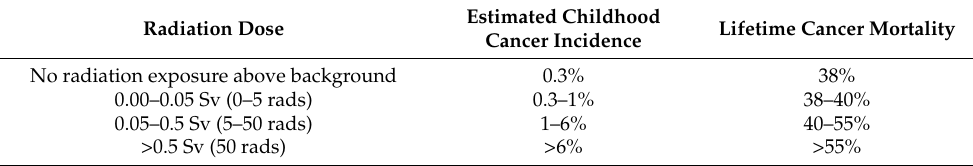
Table 2. Estimated risk for cancer in children from prenatal radiation exposure [9,25,43–49]. Radiation